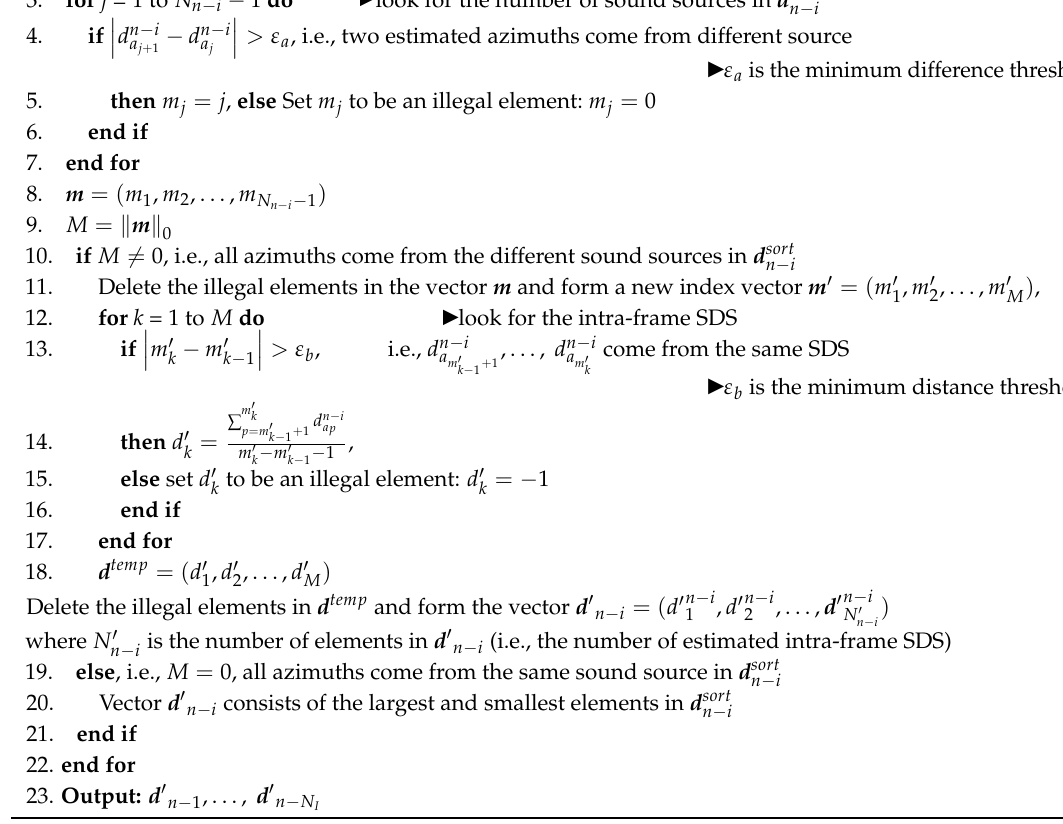
Algorithm 1 : Intra-frame SDS Discrimination